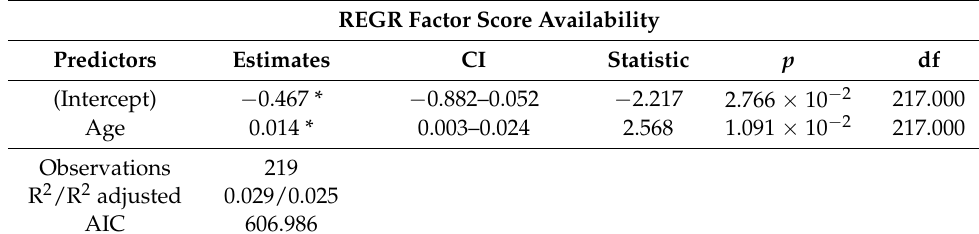
Table 12. Final regression model for